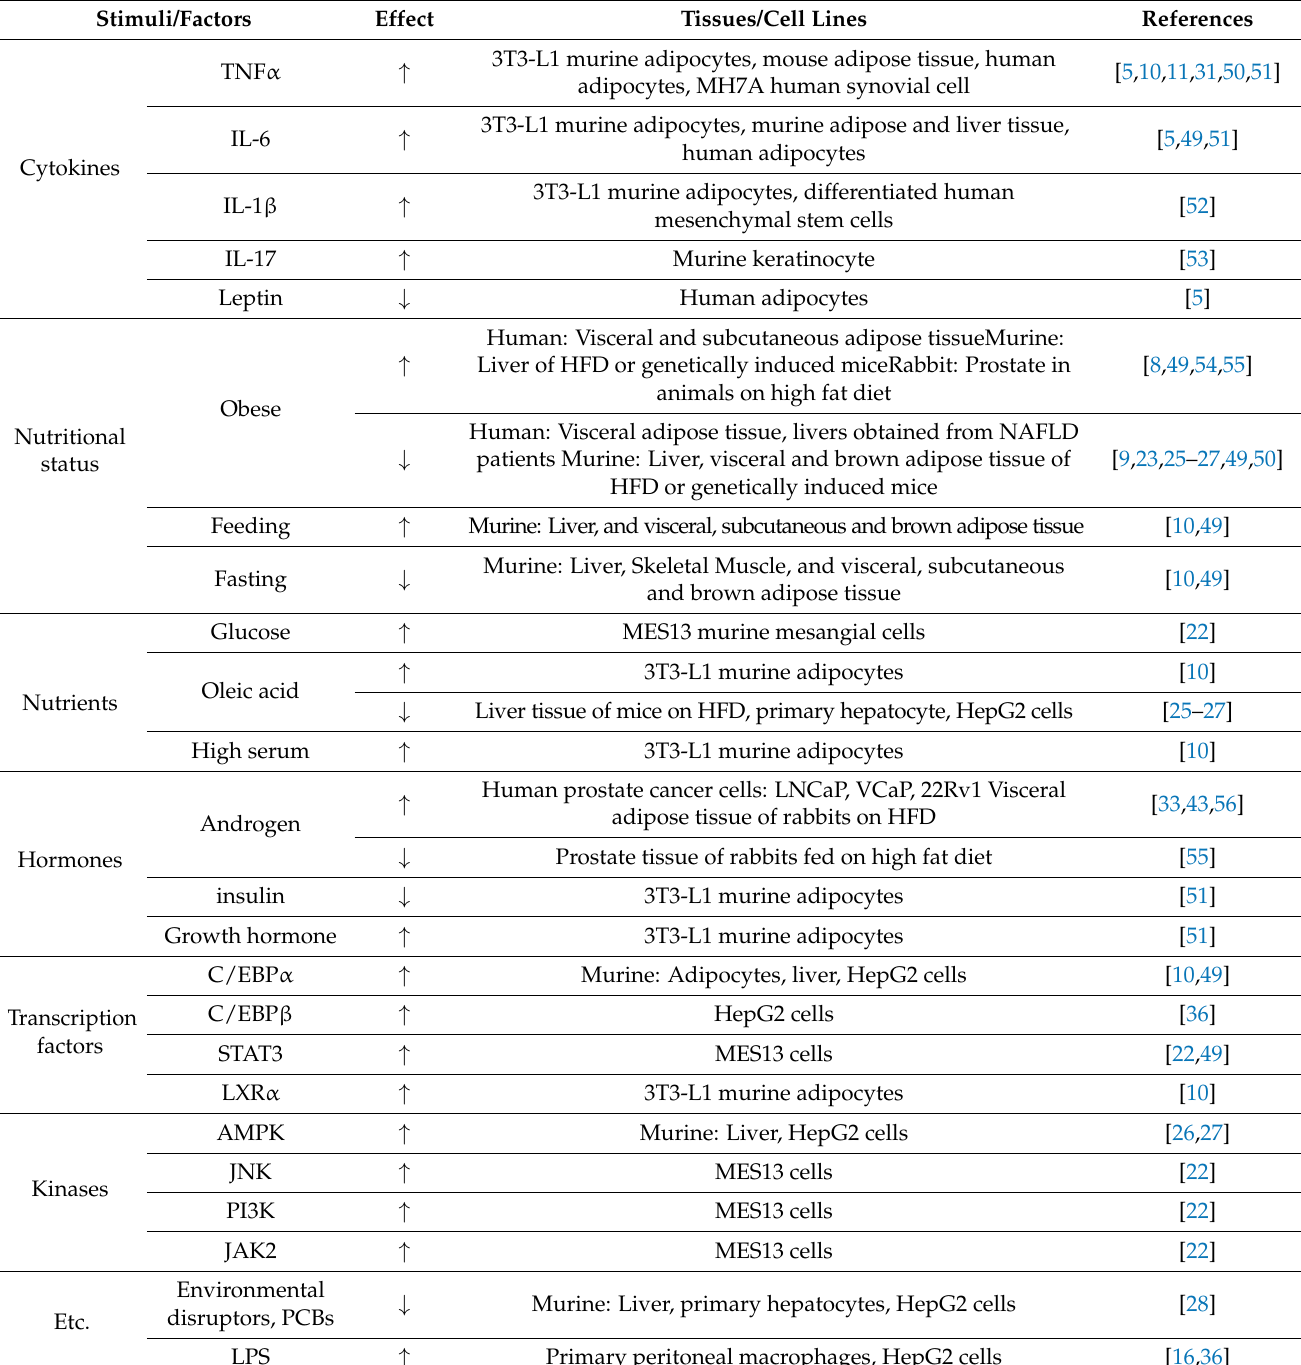
Table 1. Stimuli/factors that can regulate expression of